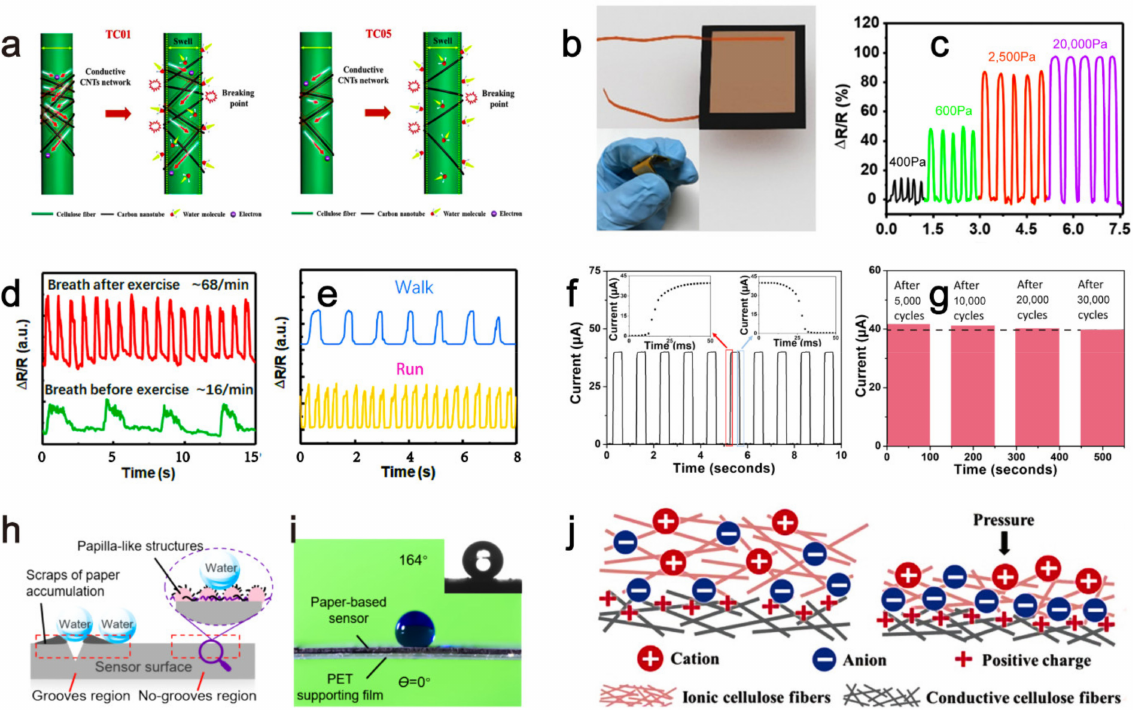
Figure 2. Paper-based sensor for physical factors sensing. ( a ) Microstructure change of carbon nanotubes caused by the cellulose swelling of water absorption. Reprinted/Adapted with permission from Ref. [18]. Copyright 2020 Elsevier